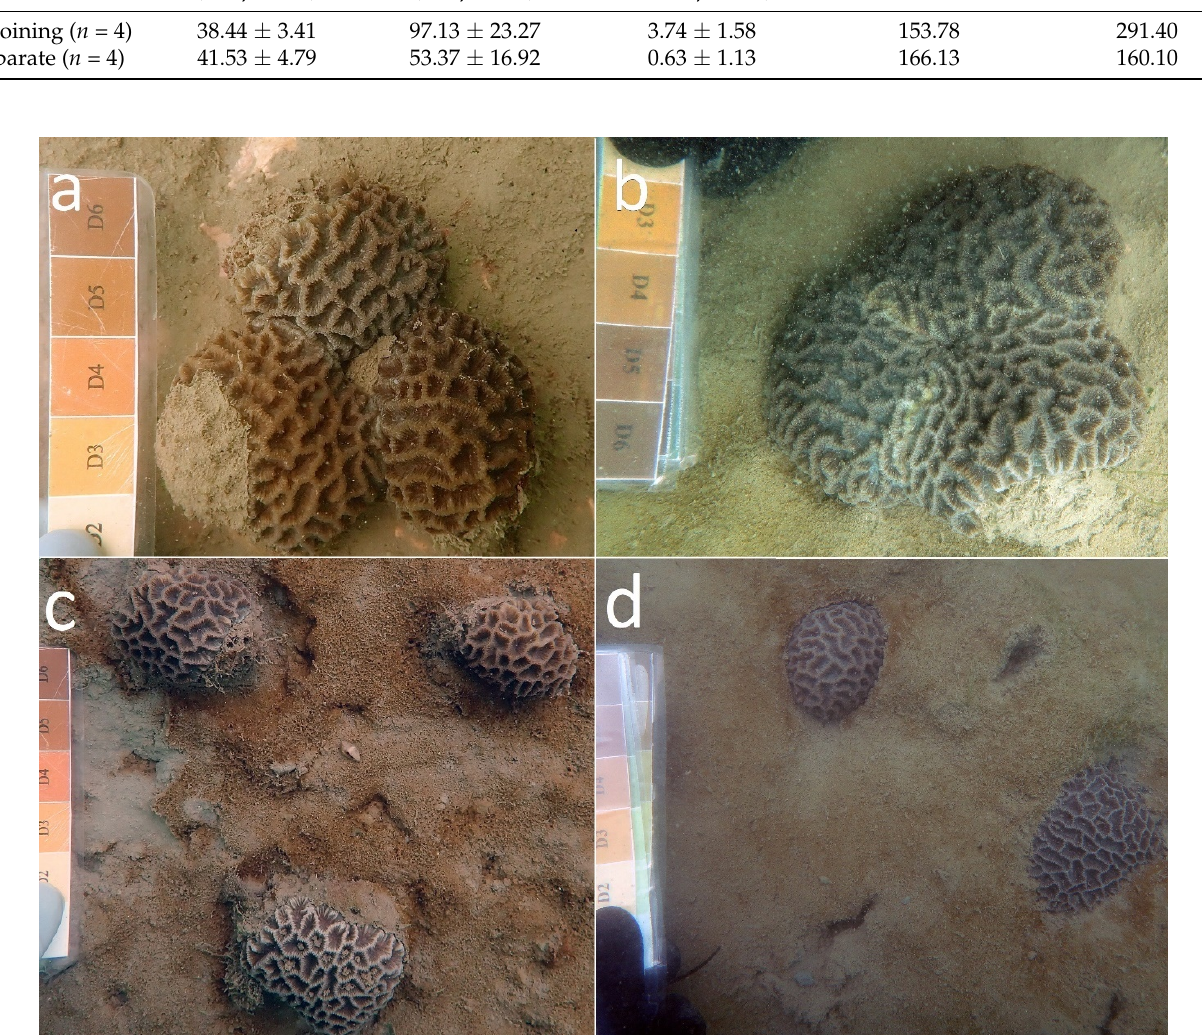
Figure 5. Representative fragments of Platygyra sinensis affected by the highly sedimented conditions at the study site: adjoining transplants in ( a ) Month 9 and ( b ) Month 15; separated transplants in ( c ) Month 9 and ( d ) Month 15. Length of each coloured square = 2 cm.